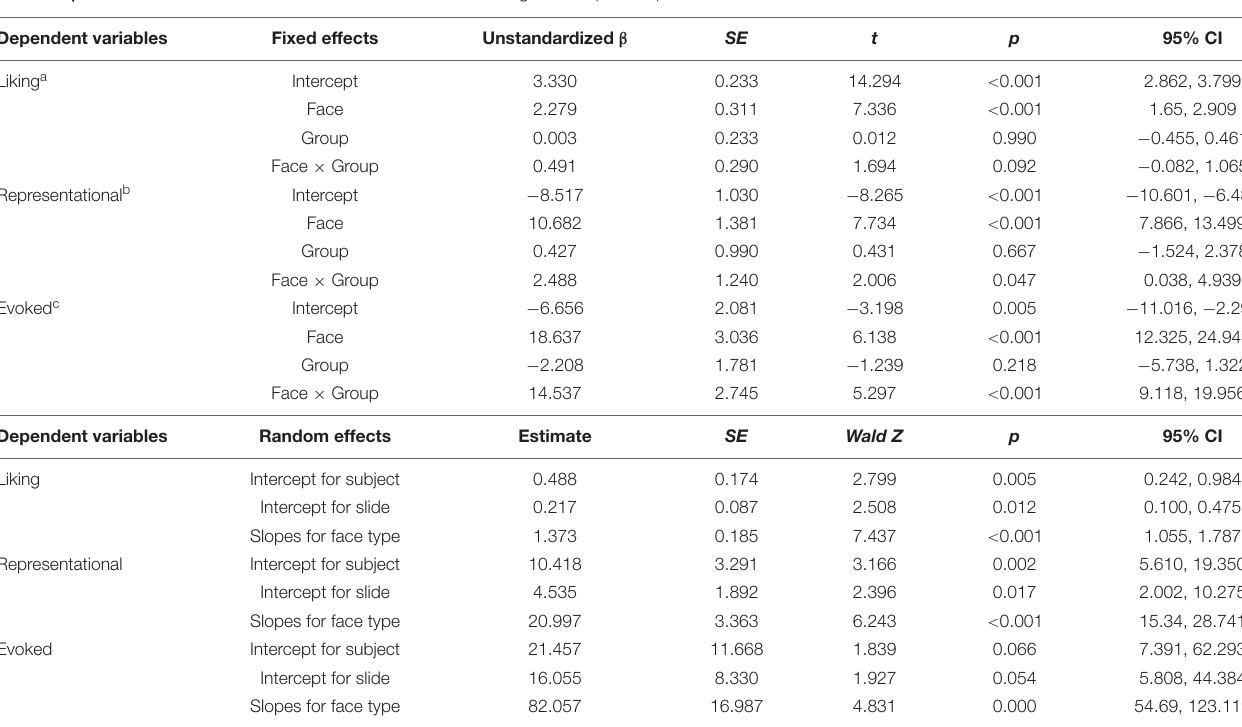
FIGURE 2 | Univariate scatterplots of the attachment state at pre- and postpriming in each group. The error bars represent ± 1 standard error (red line) of the mean (red point). TABLE 3 | Estimates of fixed and random effects in the final best-fitting models ( n =